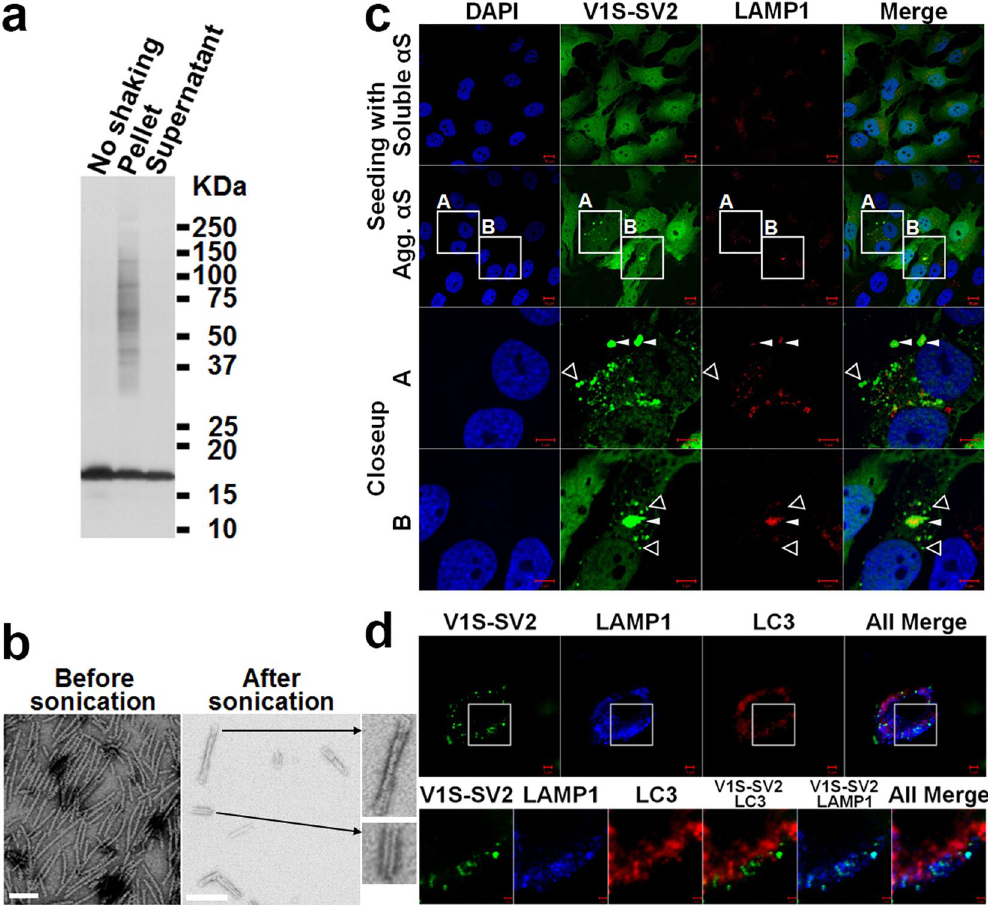
Figure 1. I n vitro α S seeds induce endo-lysosome-free and endo-lysosome-associated α S inclusions in H4/ V1S-SV2 cells. (a) Gel analysis of in vitro prepared α S seeds. Recombinant α S solution subjected to 7 days of shaking was ultracentrifuged (110,000 × g, 20 min), and the resultant supernatant and pellet were resolved by SDS-PAGE and western blotting with anti- α S antibody (Synuclein-1, 610787, BD Biosciences). A second aliquot without shaking was included as a control. (b) Electron micrographs of α S seeds before and after sonication. Scale bar: 100 nm. Different α S polymorphs are shown in close-ups. (c) H4/V1S-SV2 cells treated with sonicated α S seeds for 2 days were subjected to immunocytochemistry with primary antibody against LAMP1 followed by DAPI counterstain to demonstrate the association between endo-lysosomes and seeded α S inclusions. The bottom two rows are magnified images of frames A and B in the second row. Empty triangles and solid arrowheads denote the endo-lysosome-free and endo-lysosome-associated α S inclusions, respectively. Scale bar: 10 µ m (top two rows) and 5 µ m (bottom two rows). (d) The treated cells were further subjected to immunocytochemical staining of LAMP1 (Alexa fluor 405) and LC3 (Alexa fluor 568) to demonstrate the association between autophagosomes, endo-lysosomes, and seeded α S inclusions. Scale bar: 5 µ m (top row) and 2 µ m (bottom Results Seeding of endo-lysosome-free and endo-lysosome-associated α S inclusions by exogenous α S fibrils. It is thought that α S seeding requires both interaction of internalized exogenous seeds ( α S aggre- gates) and interaction with endogenous, intracellular α S. Although evidence to support α S seeding is still lack- ing, it has been proposed that exogenous pathogenic seeds might enter recipient cells by directly penetrating the plasma membrane or by endocytosis to initiate seeding 11–14, 22 . Accordingly, we hypothesized that α S inclusions will have a distinct cellular distribution depending on the pathway of internalization of the seeds. For exam- ple, we predicted that α S inclusions formed from seeds internalized by endocytosis, a membrane-associated process, would co-localize with endo-lysosomes; whereas those formed from direct plasma penetration (inde- pendent of membrane processes) would not. To investigate the different seeding pathways we used an H4 neu- roglioma cell-derived cell line – H4/V1S-SV2 – as described previously 16 . This cell line inducibly co-expresses the N-terminal half of Venus YFP tagged to α S (V1S) and C-terminal half of Venus YFP tagged α S (SV2). Upon TetOff induction, α S aggregation can be monitored in real-time because the interaction of V1S with SV2 upon α S- α S interaction can reconstitute fluorescence 23 . The filamentous α S aggregates used for seeding were con- firmed by SDS-PAGE/western blot and EM (Fig. 1a and b). H4/V1S-SV2 cells were treated with sonicated α S